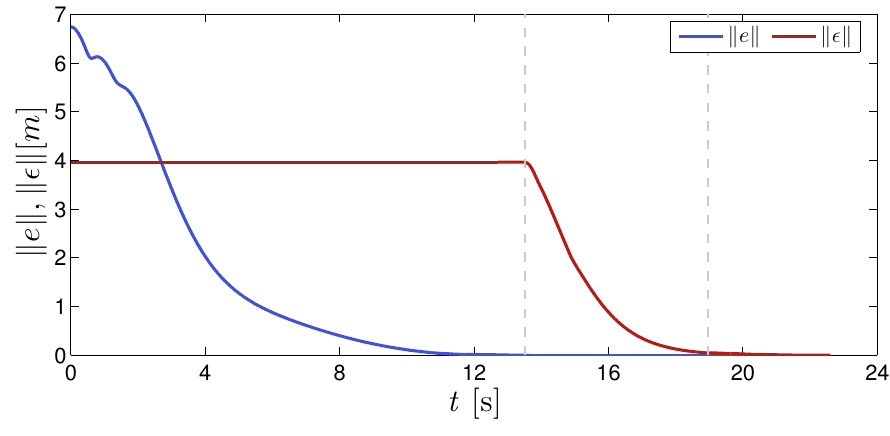
Figure 9. Norms of robot and object errors.